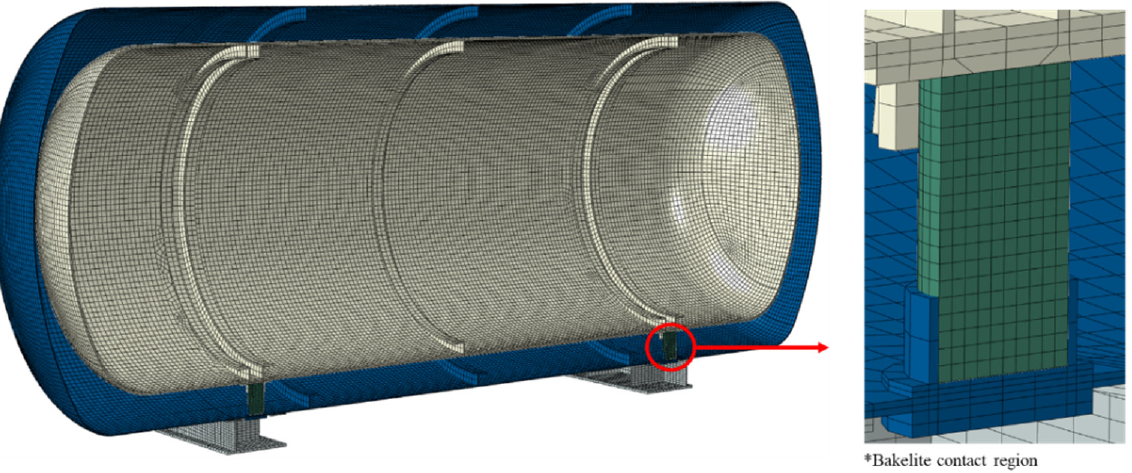
Figure 4. Finite element model of LNG fuel tank.